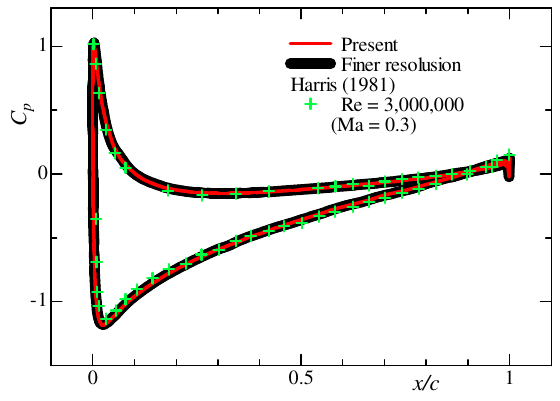
Figure 4. Pressure coefficient of the NACA 0012 airfoil.